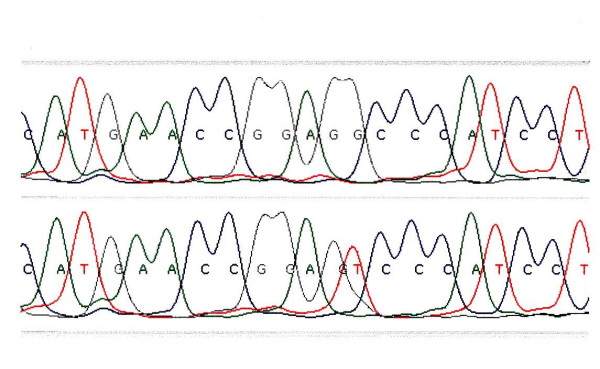
A case of ISCC showing mutation in exon 7 of the p53 gene codon 247 by single stranded conformation polymorphism and sequence analysis.